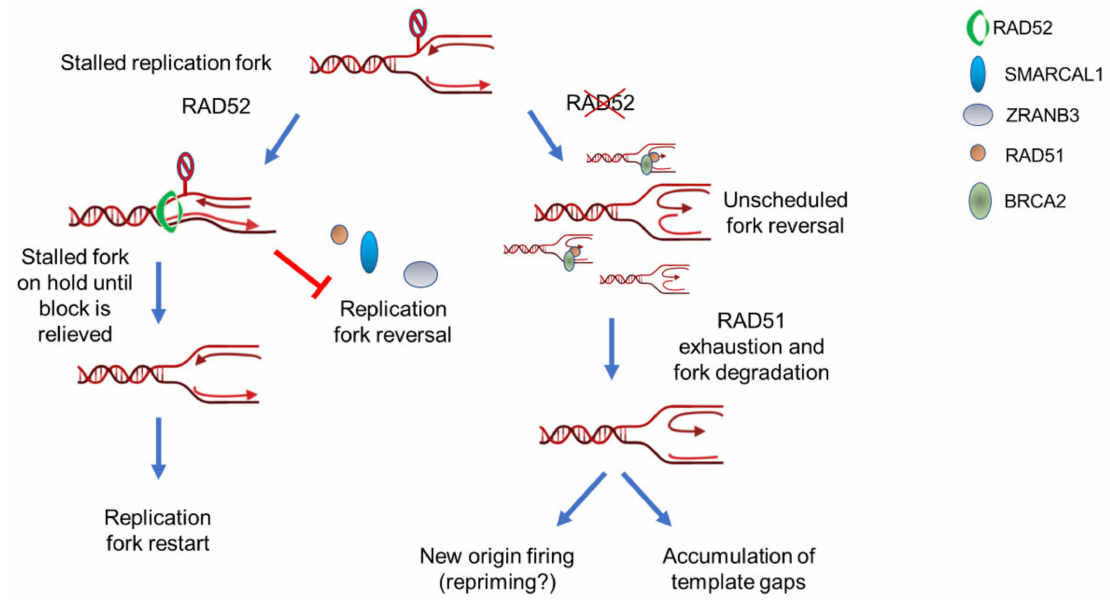
Figure2. RAD52isagatekeeperthatlimitsexcessivereplicationforkreversal. Uponforkstalling,